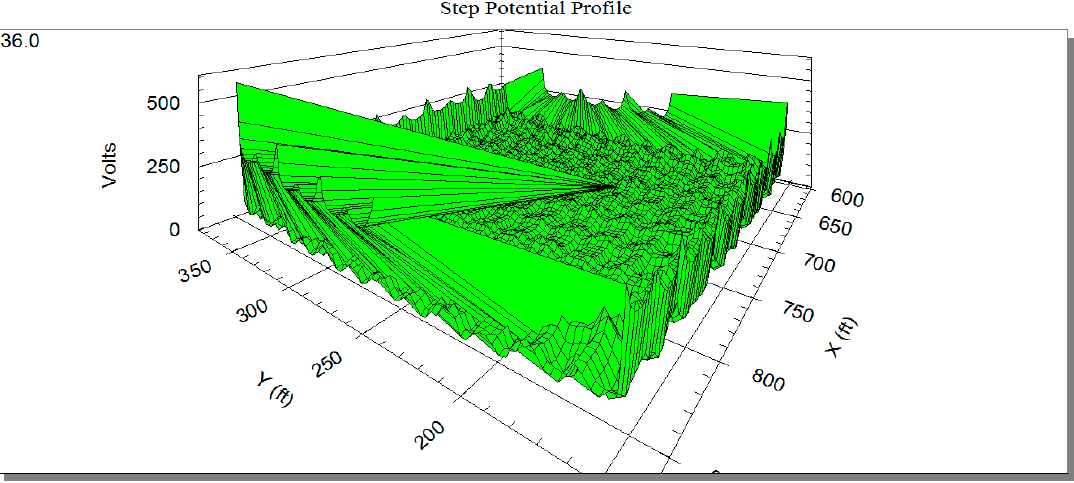
Figure 12. 3D plots of FEM mode step voltage.